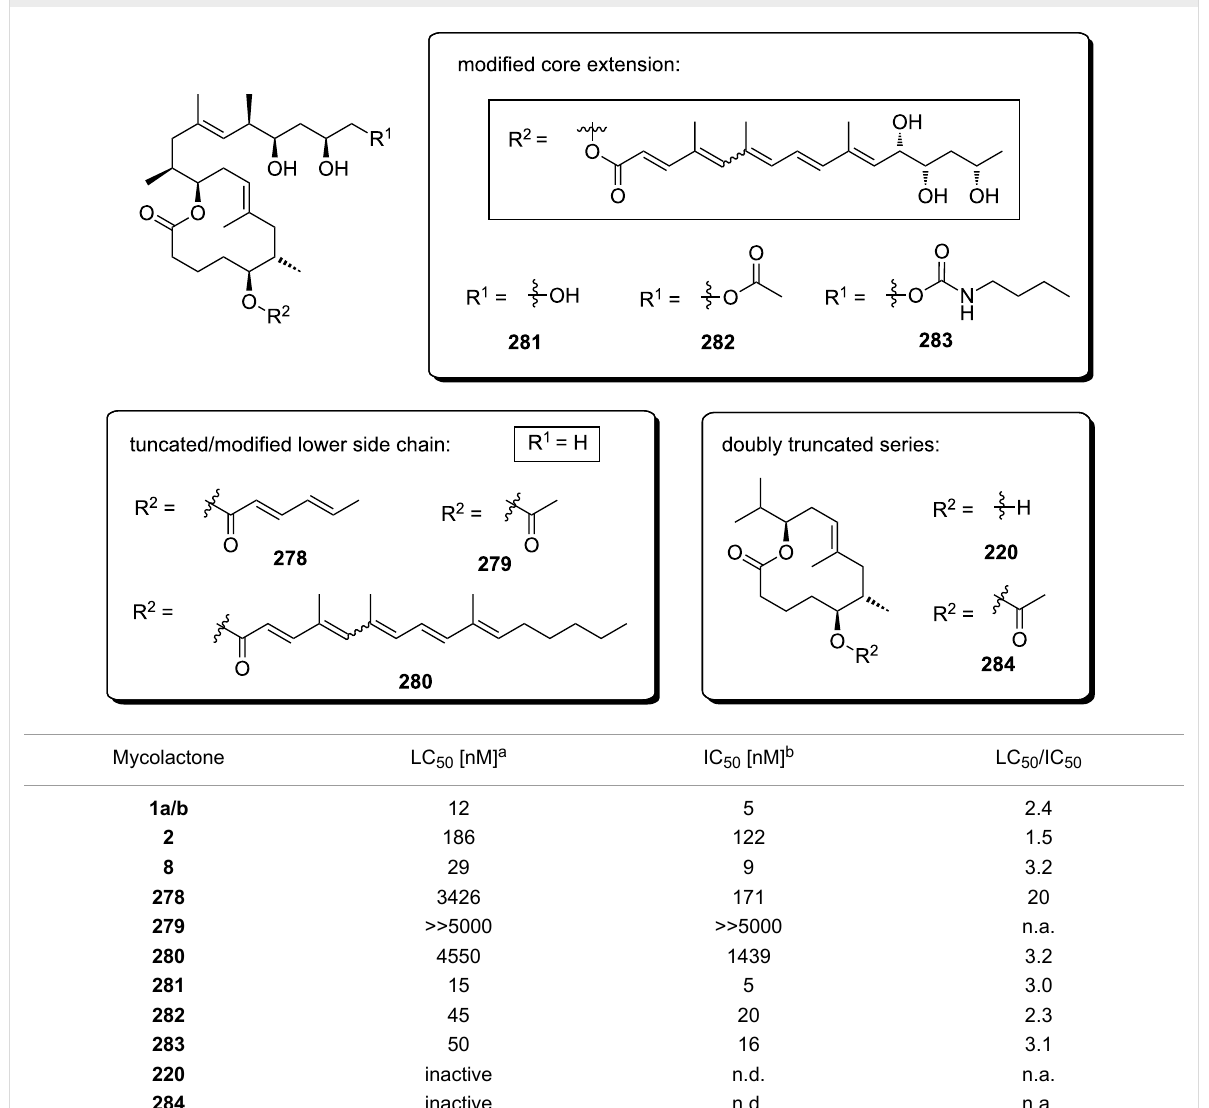
Table 2: Biological activities of mycolactones A/B, C, F, and of mycolactone